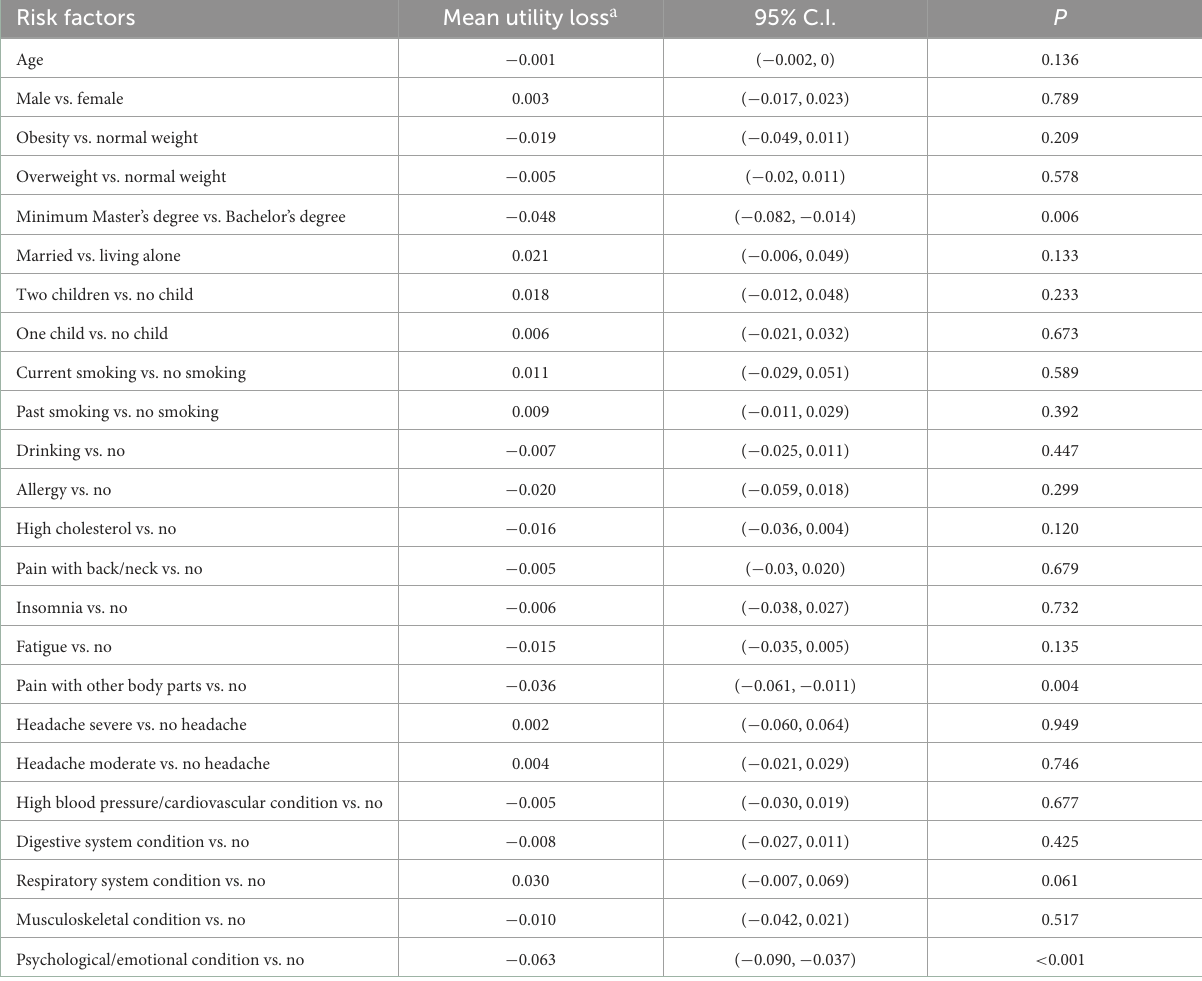
TABLE 4 Multivariate GLM simultaneously evaluating associations of individual factors with health